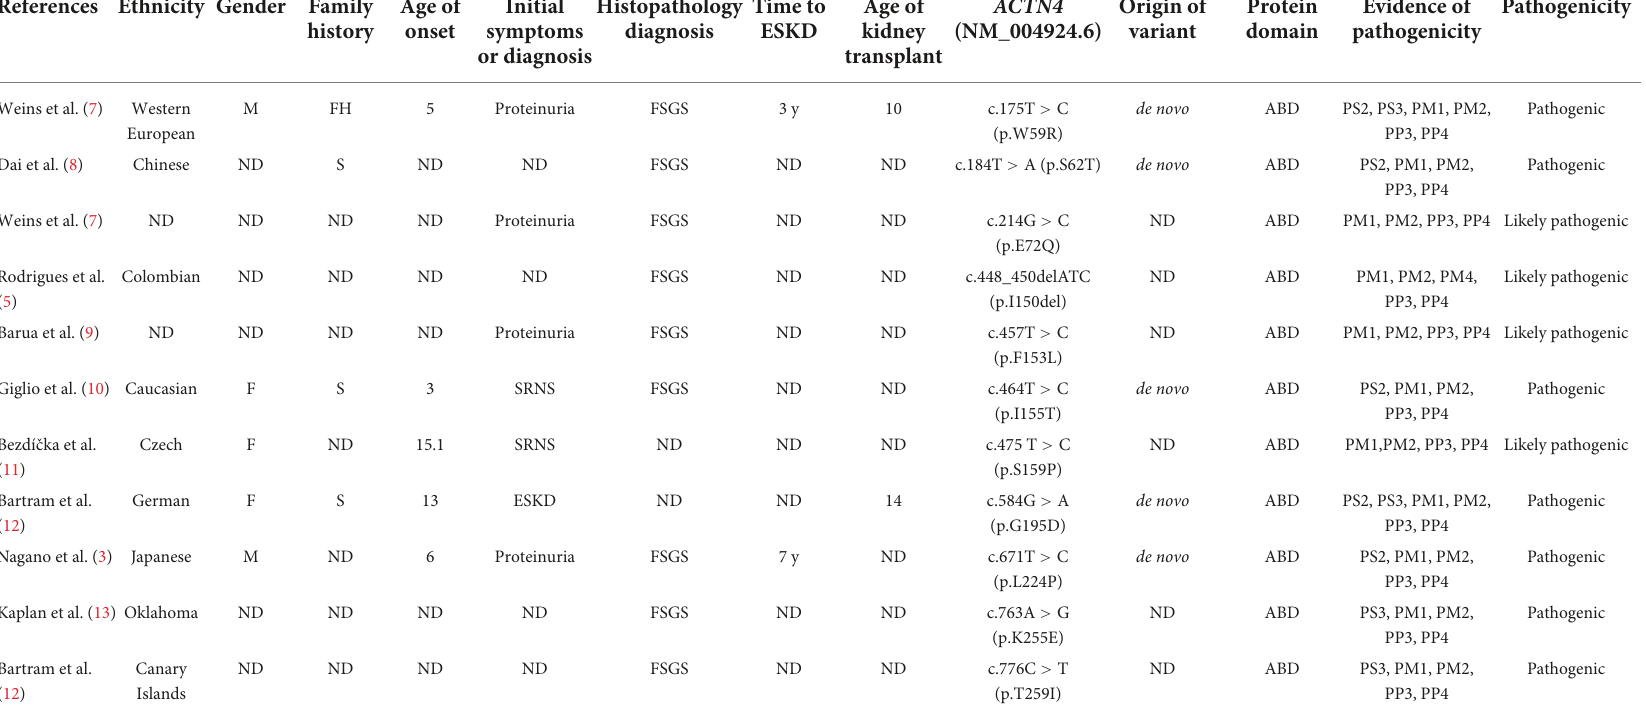
TABLE 1 Genotypes and phenotypes of patients with ACTN4 variants previously